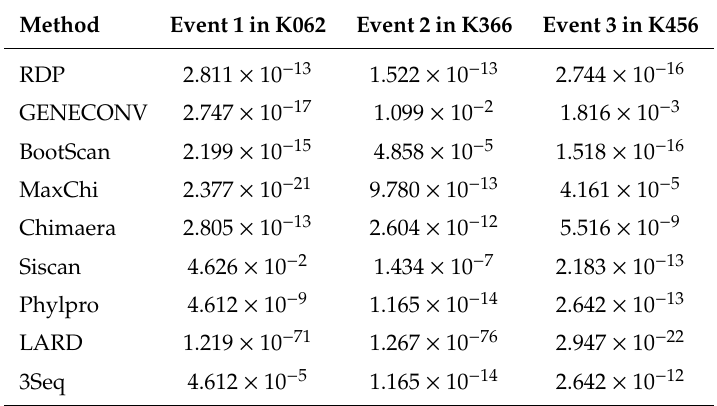
Table 2. Summary of p -values of di ff erent recombination methods using the step-down correction for multiple comparisons between our field strains and a p -value cuto ff of 0.01 in the Recombination Detection Program (RDP4, Version